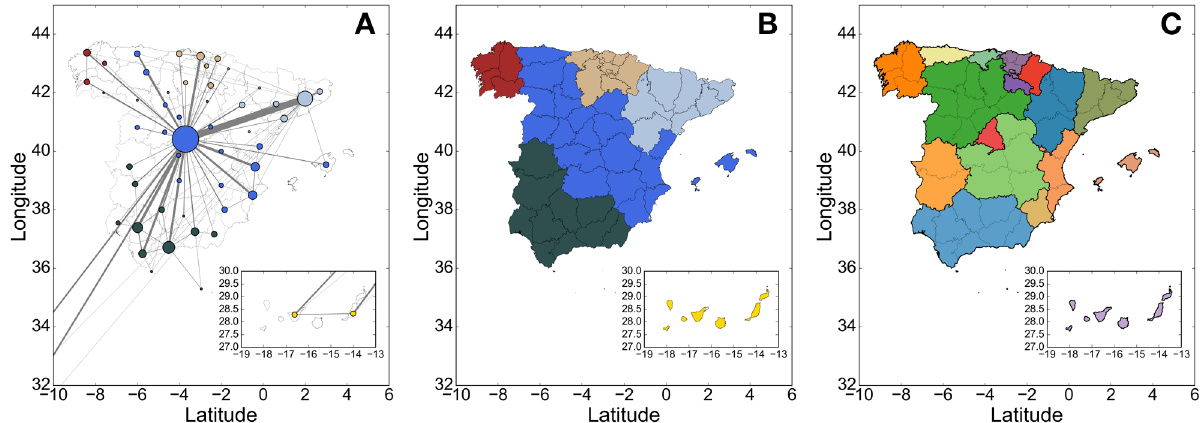
Fig 1. Network of the spending activity establishes links between regions. (A) A network of the spending activity in Spain: size of the nodes dependson the incomingactivity (i.e., bank card activity from peopleof other provinces), and color of nodesreflects their community. For the visualizationpurpose,here we take into account only the most influencing links with more than 5.3 (cid:1) 10 3 transactions that correspondto the top 5% percentile.Namely, in this scenariowe generatea network with 160 directed weightedlinks, where the weight correspondsto total amount of transactions from one province to another province. Visualization was done using Gephi . (B) The community detection algorithm, performed on the fully connectednetwork describedin the text and shown in S1 Fig, is able to identify 6 well- distinguished adjacent macro-communities. (C) Spain dividedin 17 units called autonomous